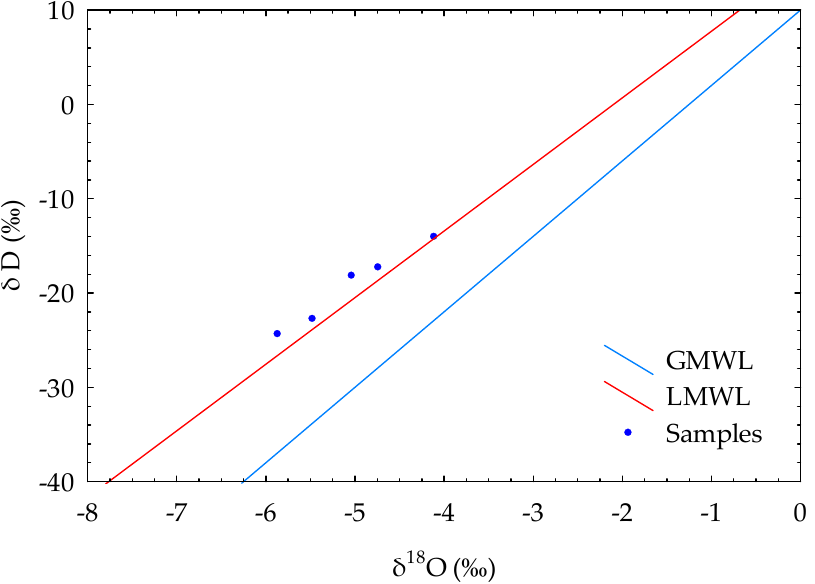
Figure 9. Plot of stable isotope composition of water ( δ 18 O and δ D) for springs investigated. Global Meteoric Water Line (GMWL) and Local Meteoric Line (LMWL) [45] for South Zagros are also reported.